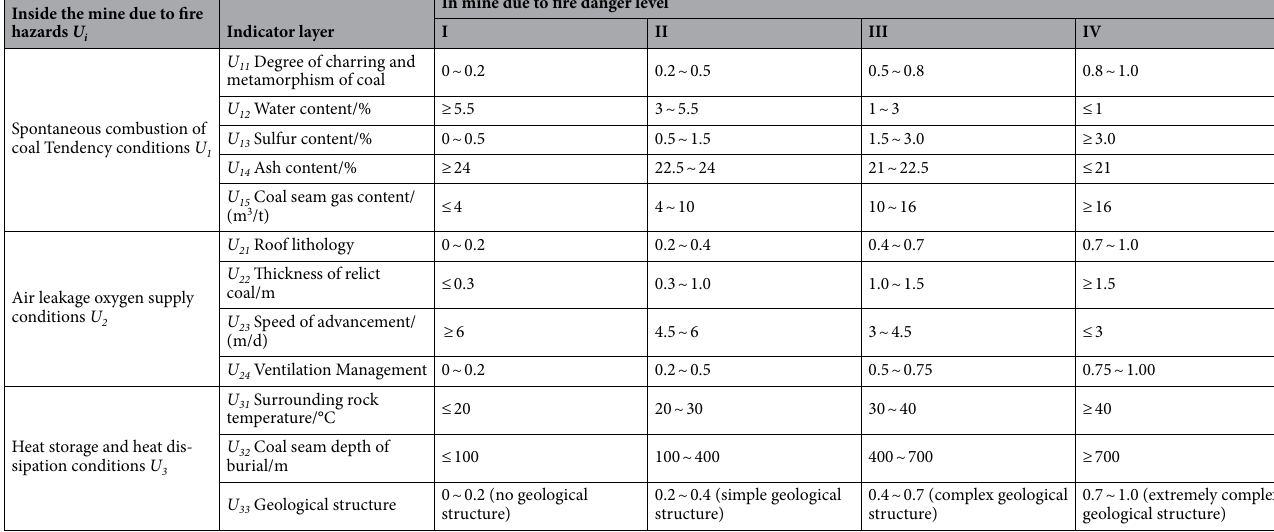
Table 1. Grades classification of influencing factor of coal spontaneous